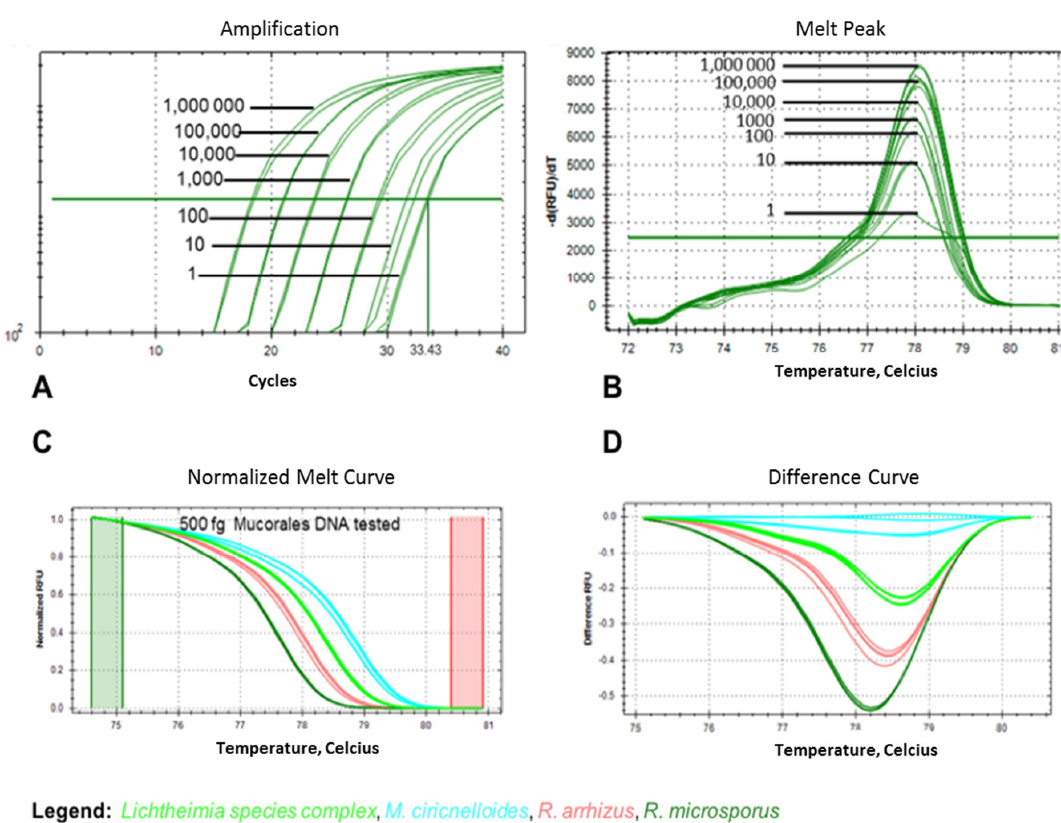
Figure 4. Limit of detection of the rnl real-time PCR-HRM in pure cultures. ( A ) Amplification of the rnl fragment for each genome copy number. ( B ) Melt peaks for each genome copy number. ( C ) HRMA melt curves for 500 fg of tested mucoralean DNA from all species under investigation. ( D ) Difference curve for species identification.